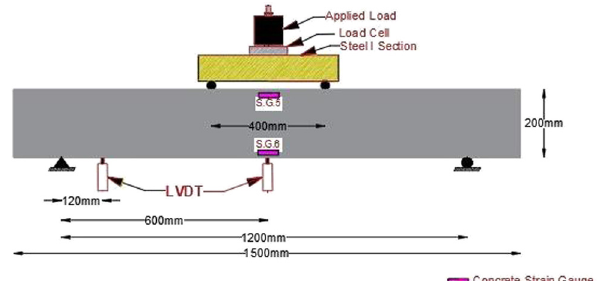
Figure 2: Details of the test set - up.